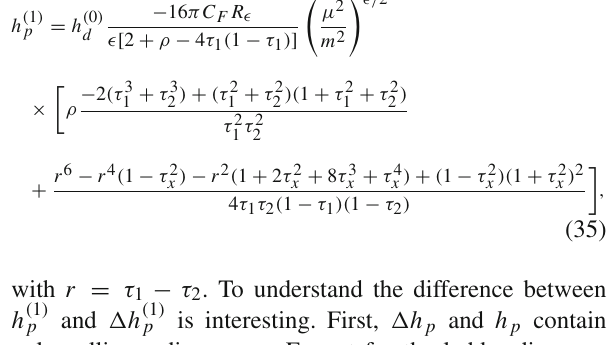
with r = τ 1 − τ 2 . To understand the difference between ( 1 ) (cid:12) h ( 1 ) (cid:12) h h p and h p contain p and p is interesting. First, only collinear divergence. Except for the ladder diagrams Fig. 3a, b, all other diagrams generate collinear diver- gence just from longitudinal real gluon. For longitudinal gluon, Ward Identities can be applied and the summed result can be expressed as the convolution of tree level par- tonic cross section and gauge link correction to PDFs(see [27] for example). The latter is the same for unpolar- ized PDF and transversity PDF. However, the divergence from ladder diagram is different. Consider ladder diagram Fig. 3b. For unpolarized case, according to the formula Eq. (10), the contribution of this diagram is proportional